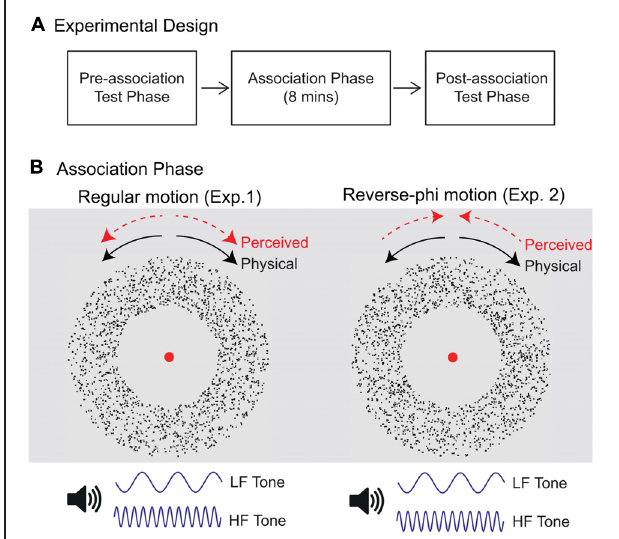
FIGURE 1 | (A) Experimental design. Each experiment consisted of three consecutive stages: pre-association test phase, association phase and post-association test phase. Pre-association (Post-association) test phase: assessment of pre-association (post-association) direction discrimination for rotating stimuli either presented with static sounds or alone. Association phase: pairing of rotation directions with static sounds of distinct frequencies. (B) Stimuli used during the association phase. In Experiment 1,regular motion was presented with static tones. Each rotation direction [clockwise (CW) or counter-clockwise (CCW)] was paired with either low-frequency (LF) or high-frequency (HF) tones. Reverse-phi motion was used in Experiment 2. The perceived direction of rotation (as shown by dotted red arrows) was in the direction opposite to the physical displacement (black